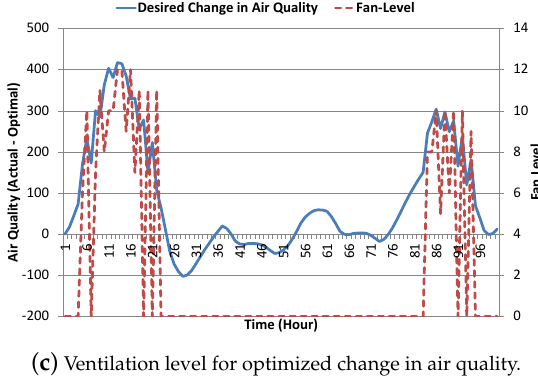
( a ) Heating level for optimized change in temperature.